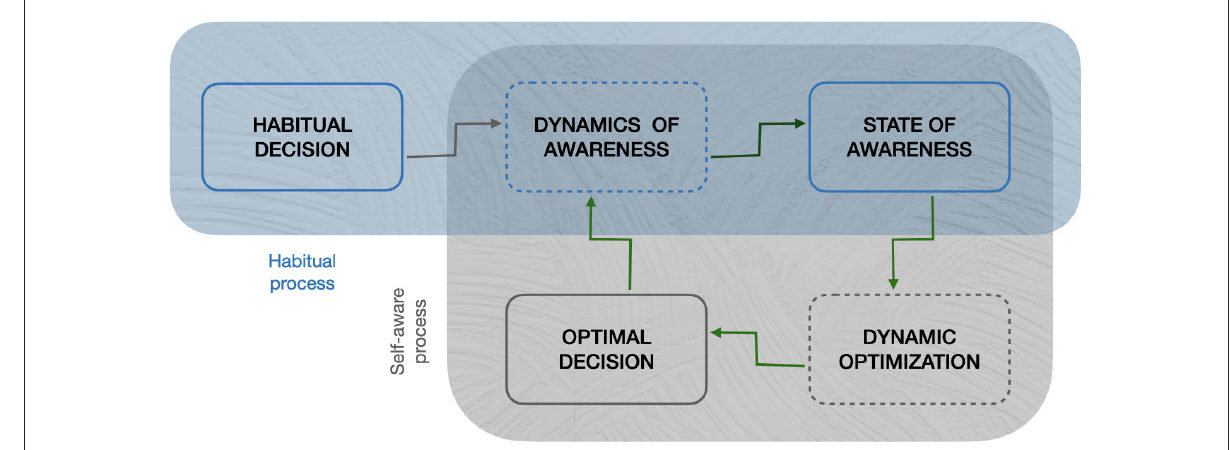
FIGURE5 A schematic logical representation of the model. The blue (green) circle indicates the structure in the case of habitual ( self-aware or equivalently optimal ) decisions and their intersection. The dashed borders of the two blocks relative to the dynamics symbolize the uncertain factors impacting the dynamic in